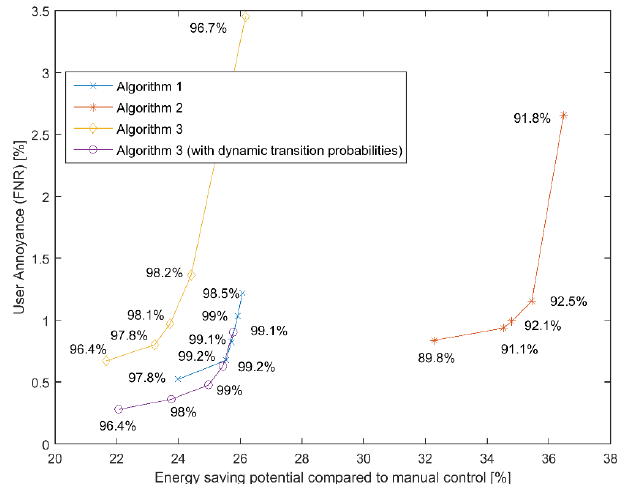
Figure 6. Trade-off between user annoyance, expressed by the percentage of false negatives and energy saving potential during the implementation phases. The accuracy of each algorithm is also